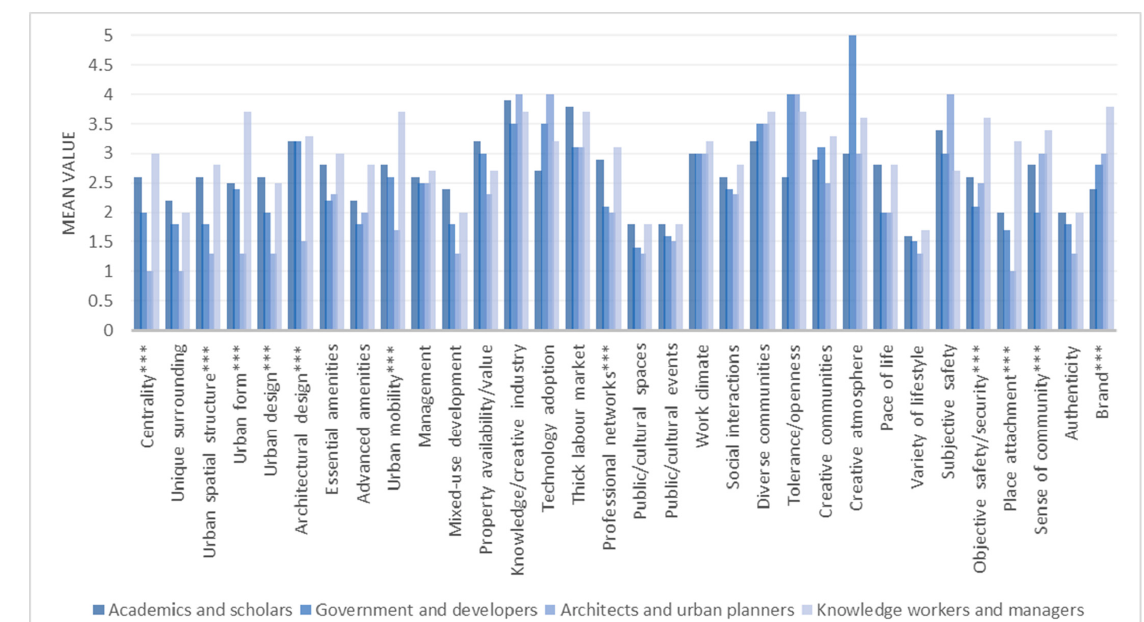
Figure 2. Quantitative evaluation of place characteristics in Diamantina Knowledge Precinct.